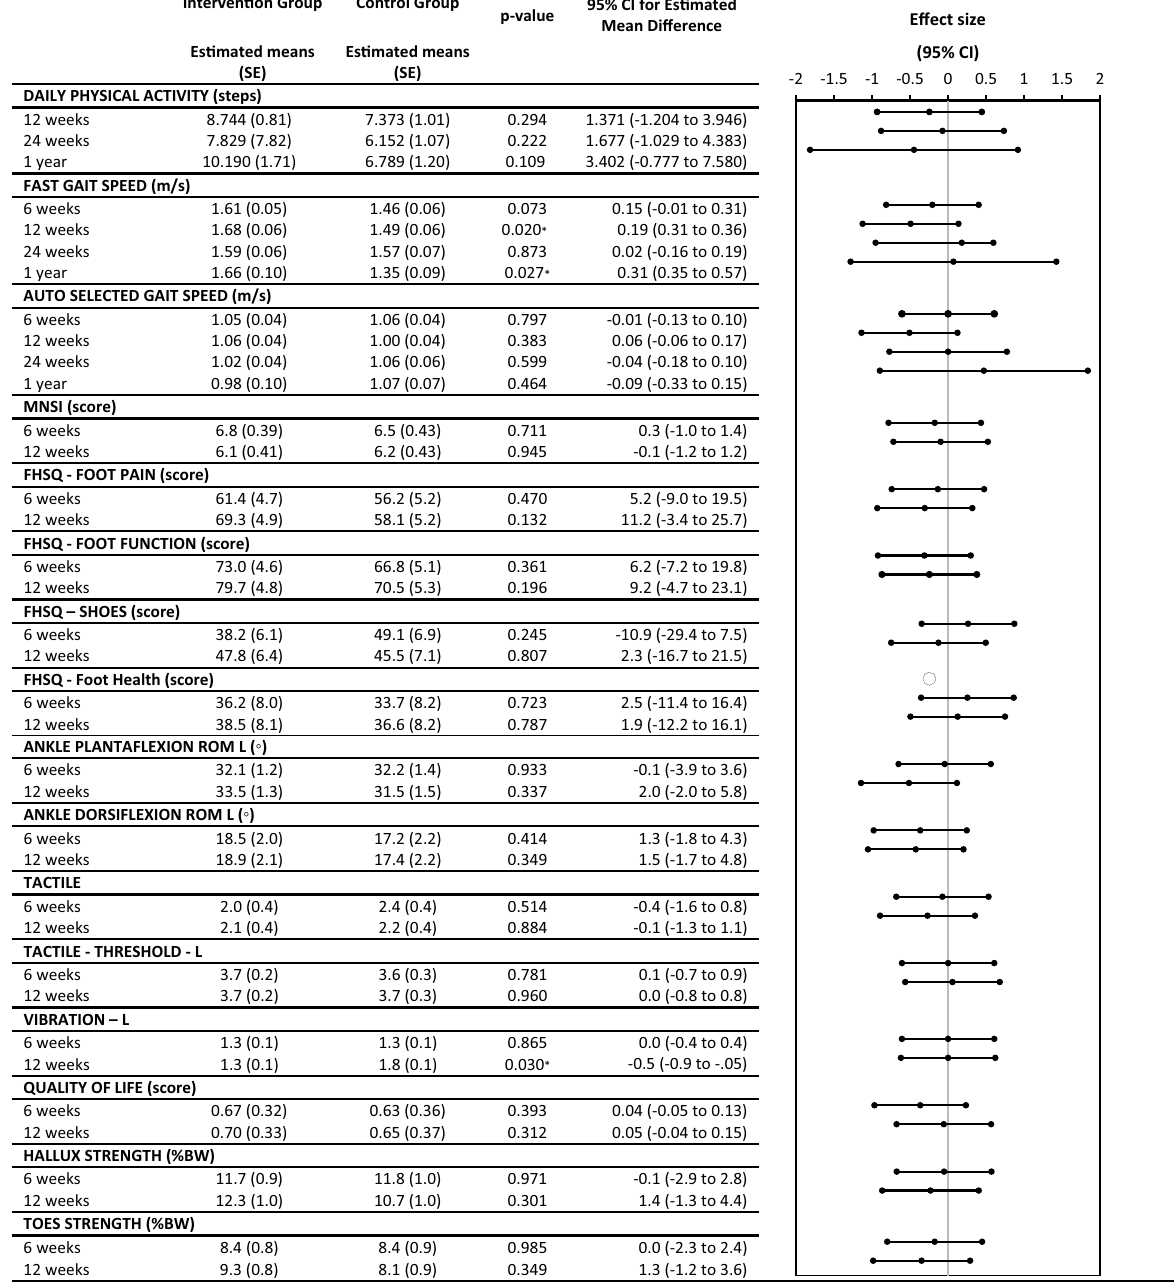
Table 2. Secondary and primary outcomes from intervention group and control